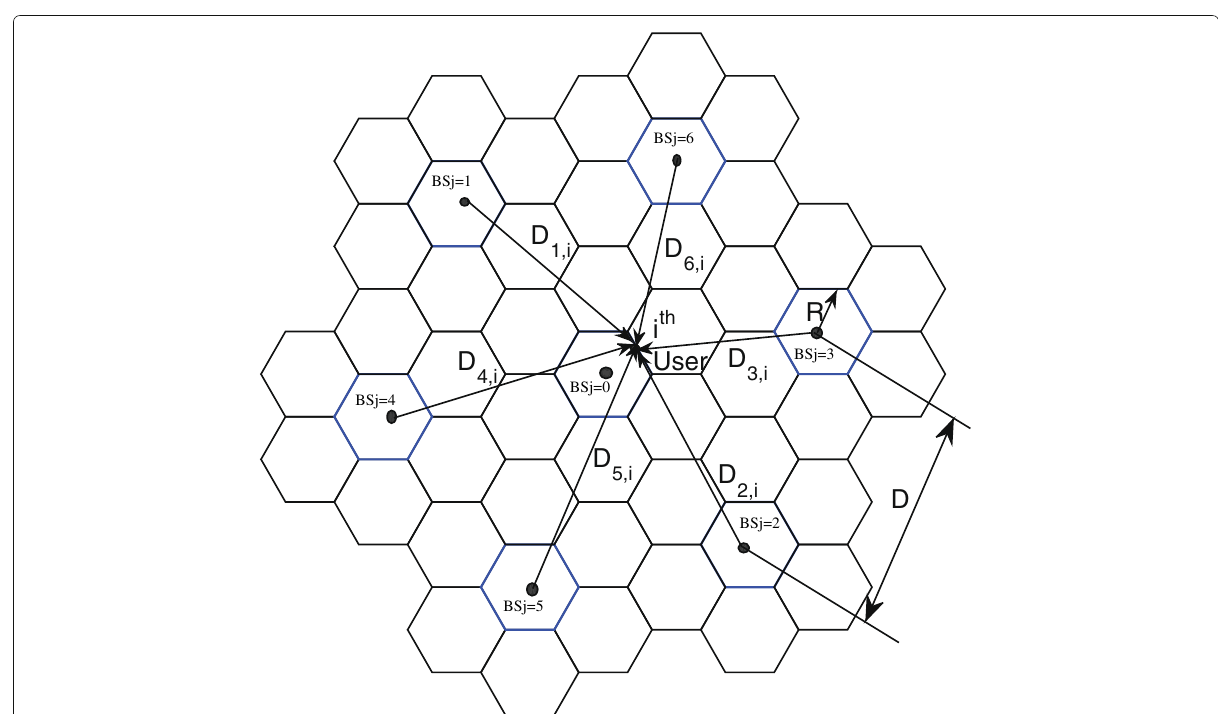
Fig. 1 Hexagonal cellular network. D reuse distance, R cell radius, and D j , i interfering